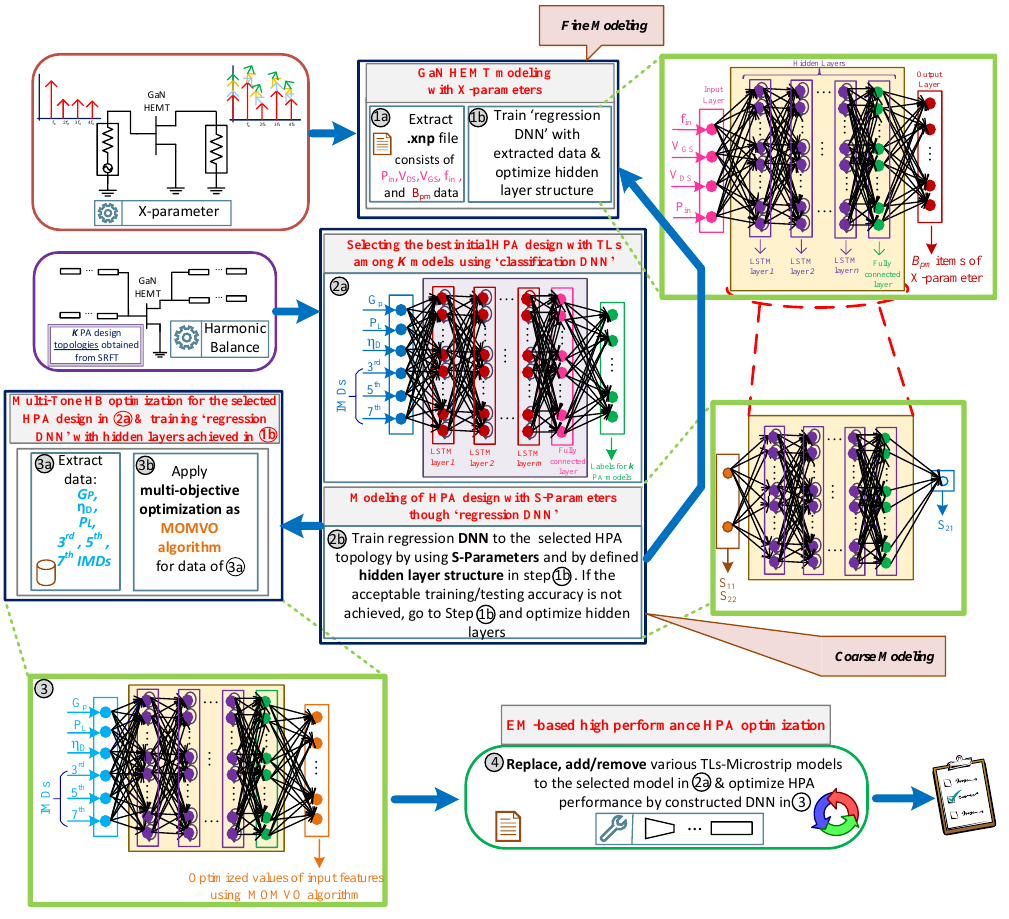
Figure 1. An overview of the proposed coarse and fine optimization method for modeling transistor and optimizing HPA designs with DNNs where multi-objective algorithm is